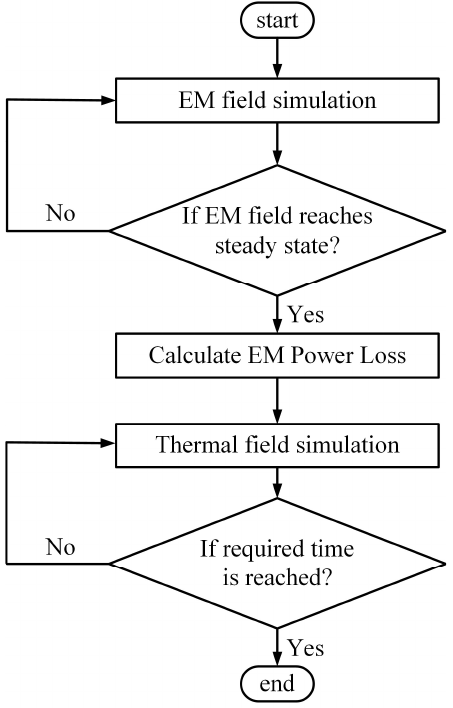
Figure 1. The flowchart of EM-T co-simulation.